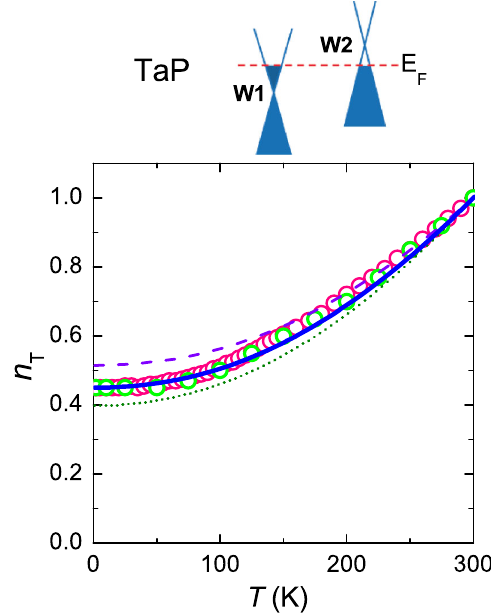
FIG. 3. Temperature dependence of n for samples TP1 (red T circles) and TP2 (green circles) derived from the extended Kohler ’ s rule Eq. (1). The dashed, solid, and dotted curves are calculated electron densities from Eq. (2) with energies ( E 1 and E 2 ) (relative to the Fermi level) of the Weyl nodes W1 and W2 of ( − 53 . 1 meV, 19.6 meV), ( − 46 . 2 meV, 19.6 meV), and ( − 40 meV, 24 meV), respectively. To show the temperature dependence rather than their absolute values, all the calculated curves are normalized to the values at T ¼ 300 K. Schematics of the electronic band structures are presented on the top of the